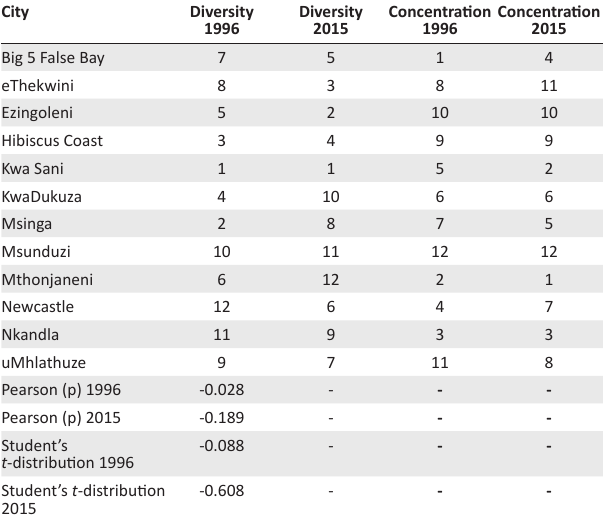
TABLE 6: Size diversity of KwaZulu-Natal